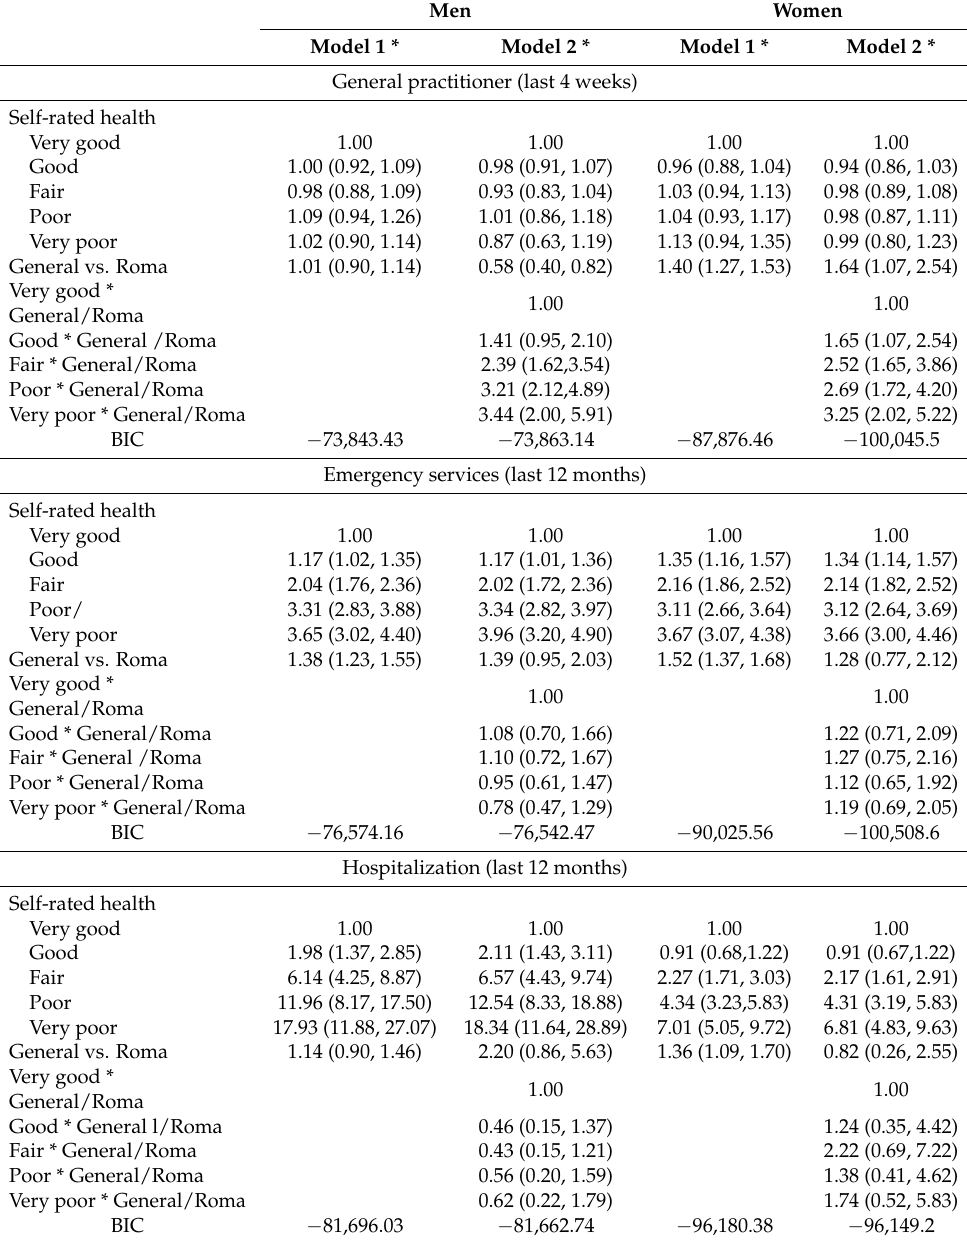
Table 2. Prevalence ratios (with 95% CI) for the use of healthcare services according to health need (self-rated health) for men and women. Men Women Model 1 * Model 2 * Model 1 * Model 2 * General practitioner (last 4